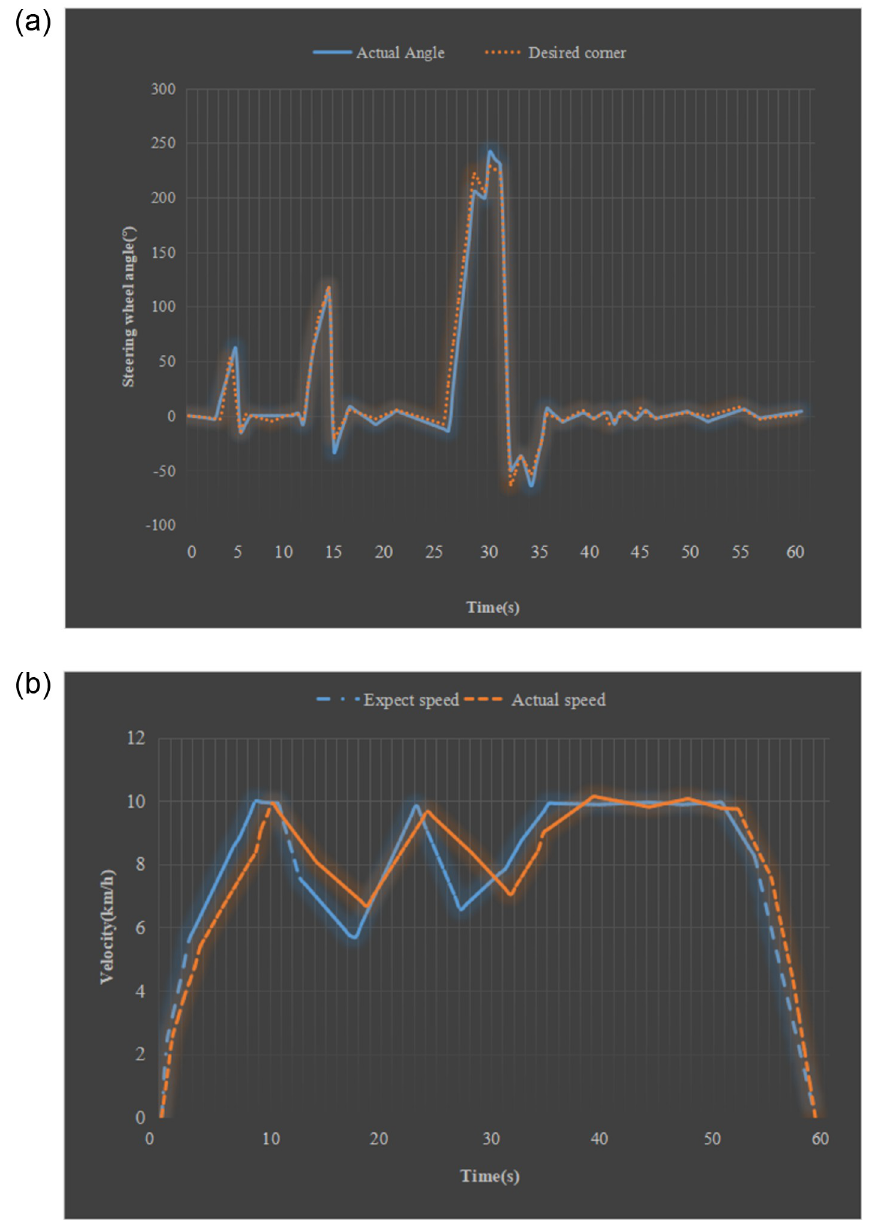
Fig 10. Experimental results of the vehicle control system (a) steering wheel angle curve (b) speed curve.